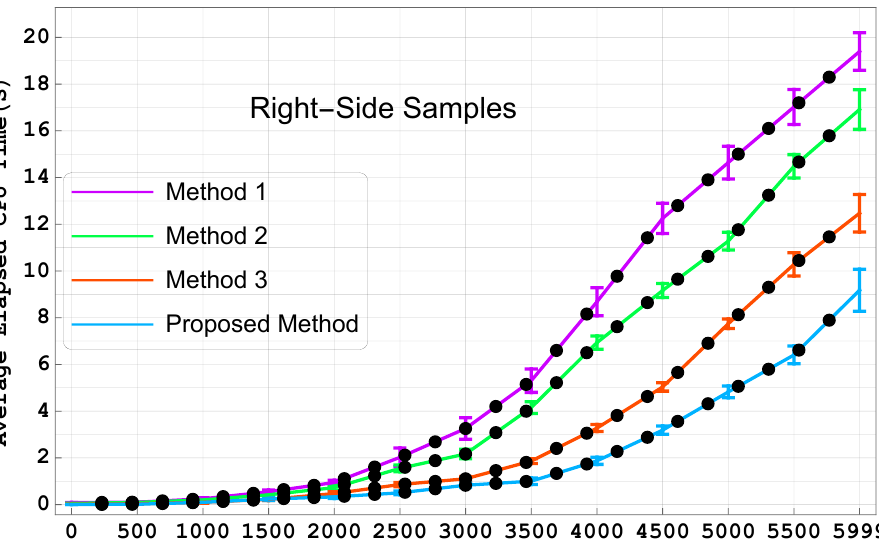
Figure 17. Average elapsed CPU times in seconds with error bar: Computation of full set of KMs for right-side samples of the speech signal of size 3000 shown in Figure 15c. Assuming p =